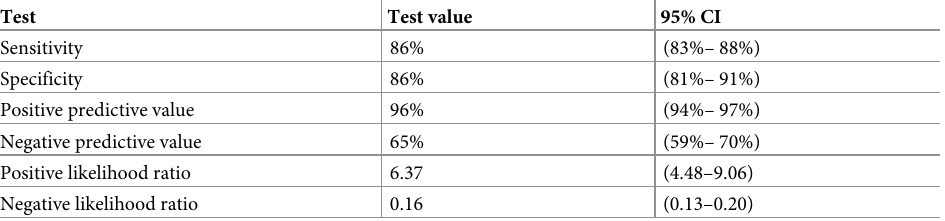
Table 4. Measures of validity and 95% confidence intervals for self-reported past three-day methamphetamine use compared to urine toxicology screening (N =